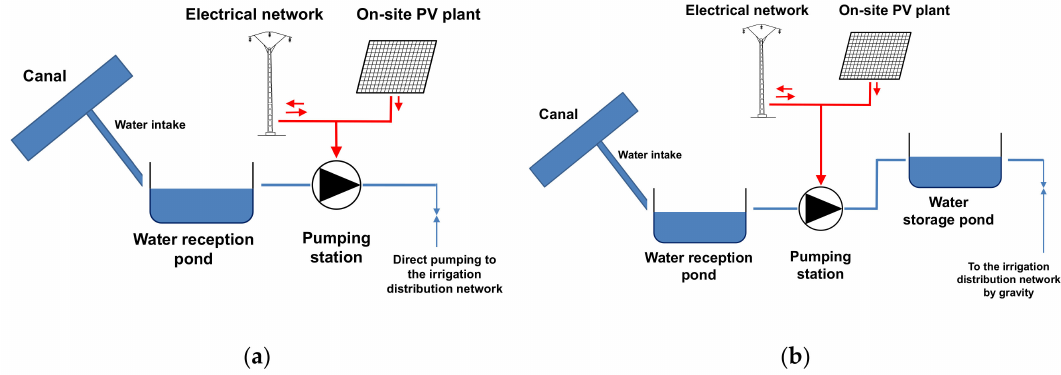
Figure 1. Scheme of operation of pumping stations: ( a )direct pumping; ( b ) with water storage